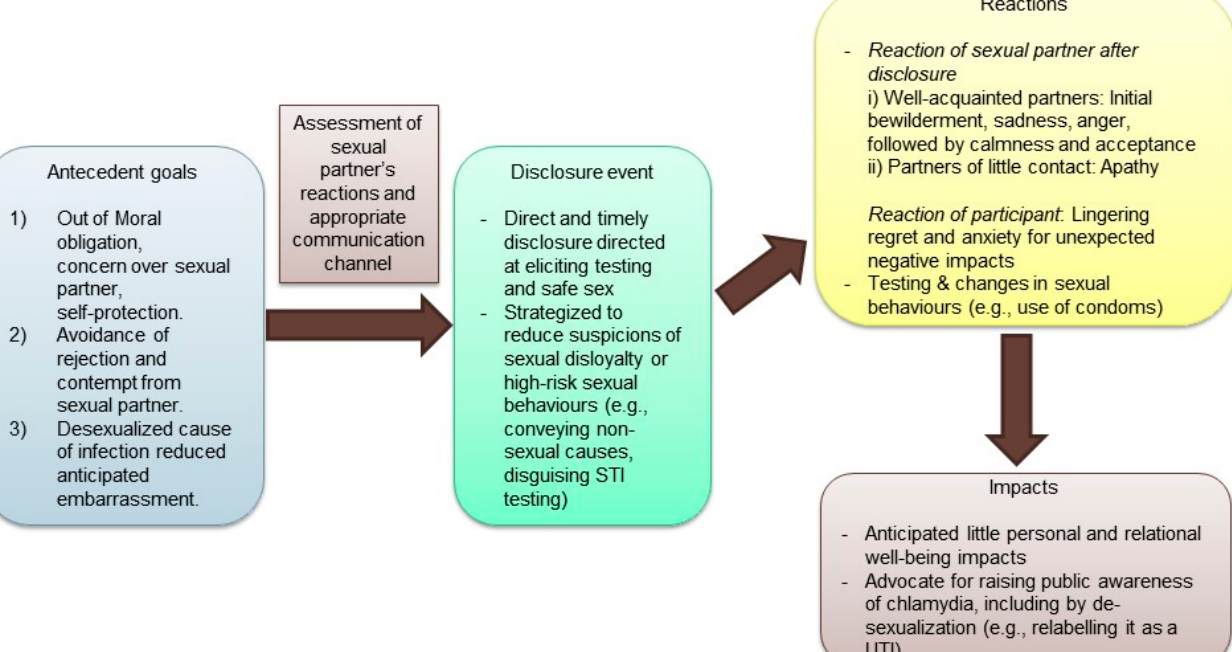
Figure 1. Model on partner disclosure of chlamydia in Hong Kong Chinese.